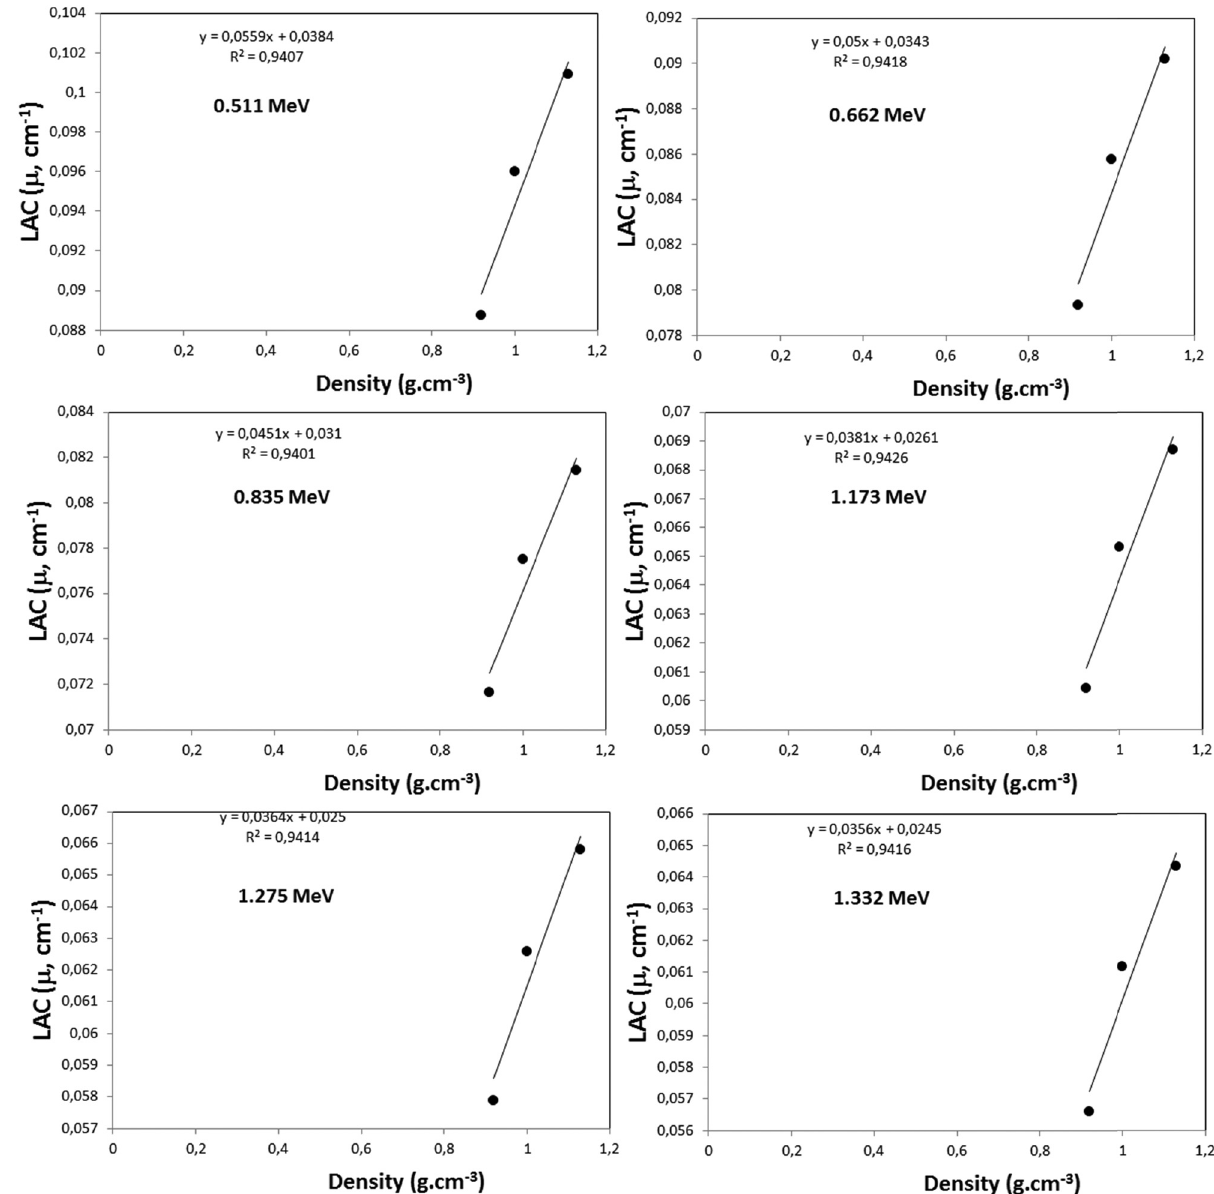
Figure 3: The calculated LAC as a function of